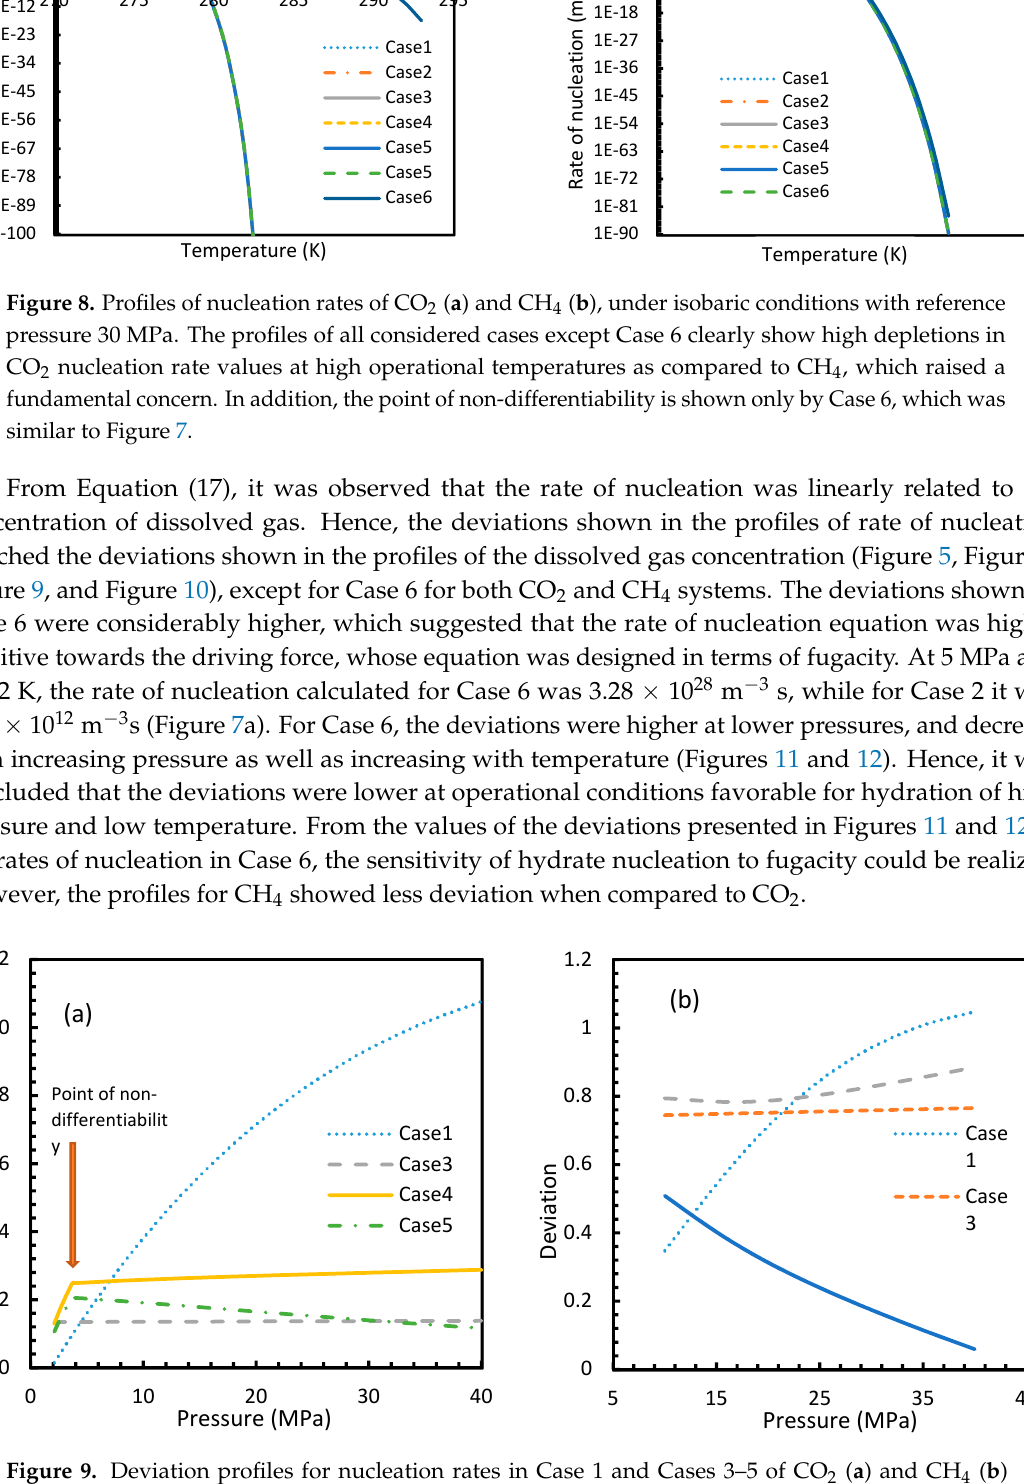
Figure 7. Profiles of nucleation rates of CO 2 ( a ) and CH 4 ( b ), under isothermal conditions with the reference temperature of 273.2 K. The profiles clearly show high rates of nucleation when CO 2 was used as the guest gas compared to when CH 4 was used. In addition, unlike the profiles of gas concentration in aqueous phase, the point of non-differentiability is shown only by Case 6.